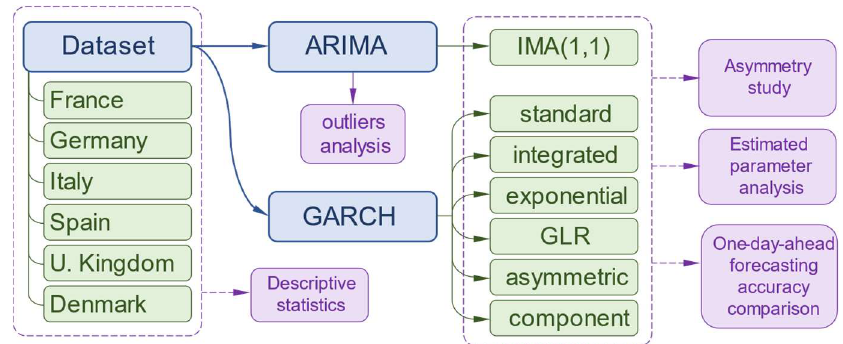
Figure 1. Flow diagram of the analysis performed.